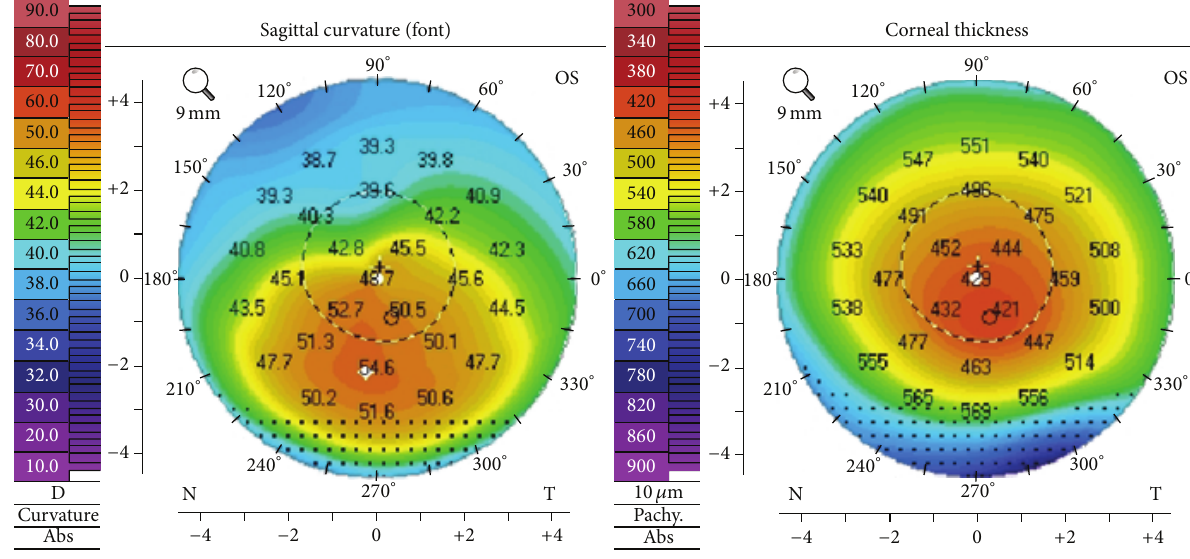
Figure 2: Corneal topography of the left eye showing stage II